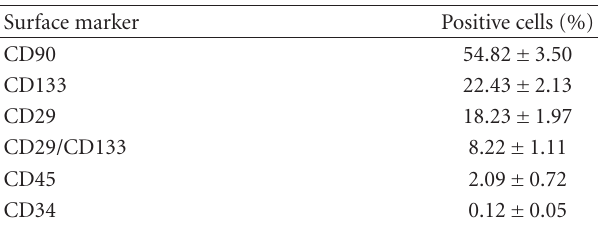
Table 2: Phenotypic characterization of rat brown adipose-derived cells ( n =